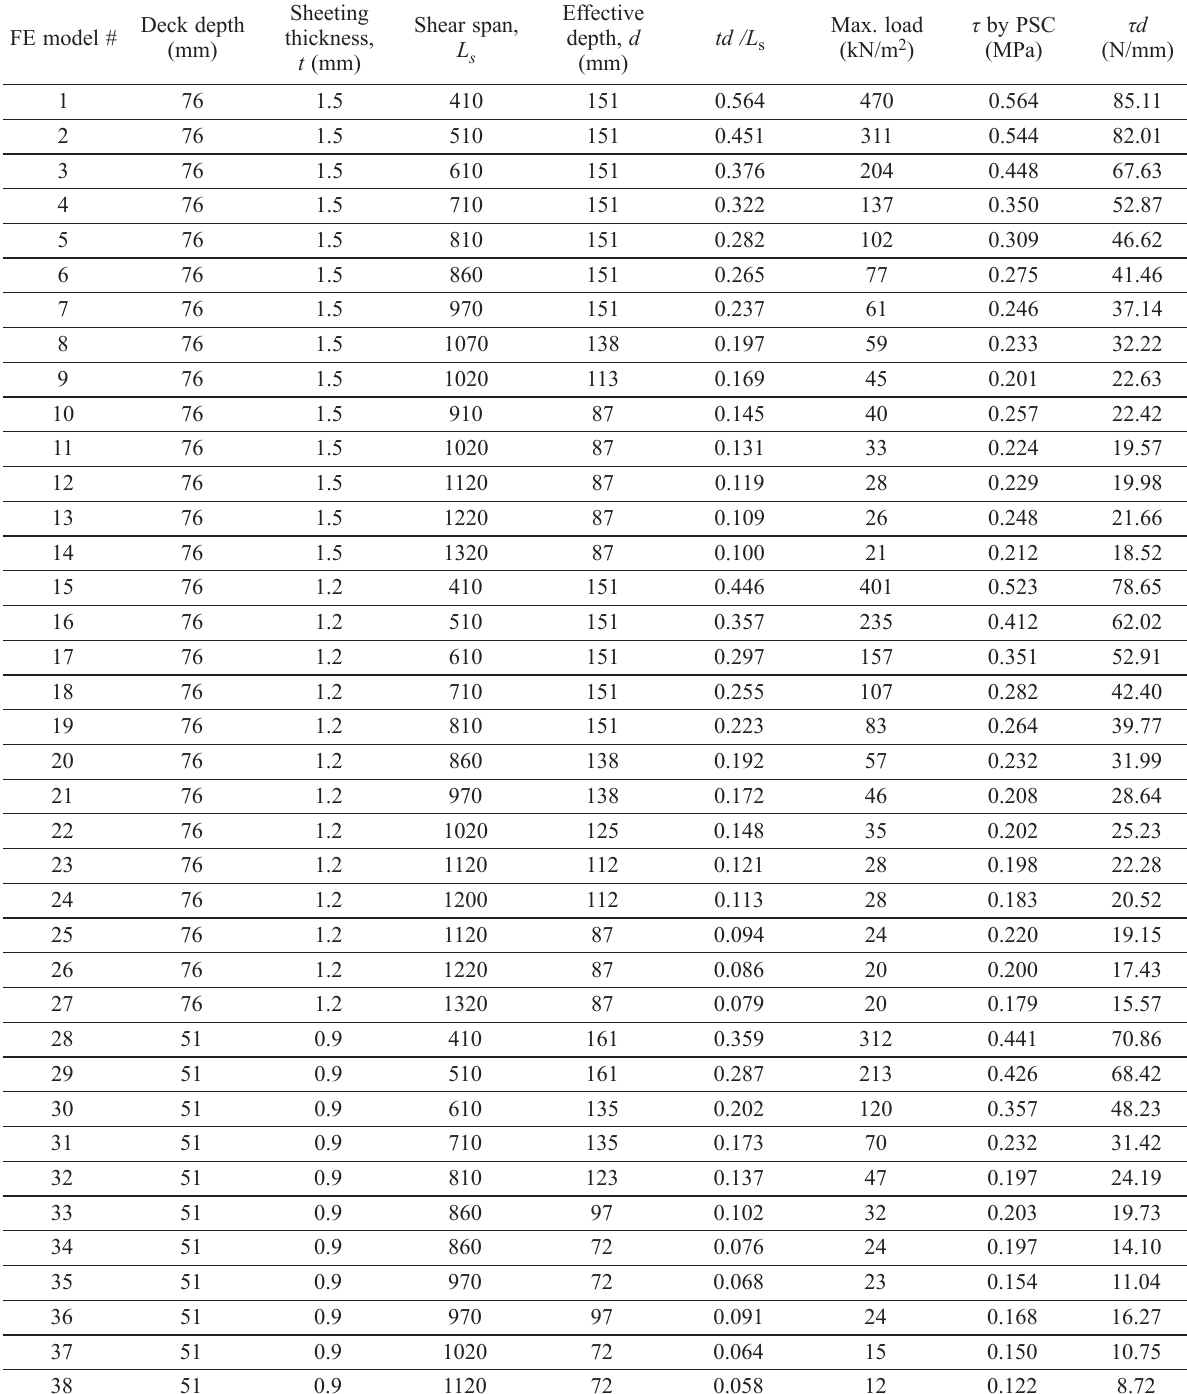
Table 2. Results from FE analyses of slabs using 76 mm deck with 1.5 mm and 1.2 mm sheeting thicknesses and 51 mm deck with 0.9 mm sheeting thickness (Abdullah, Easterling 2009) Deck depth FE model #